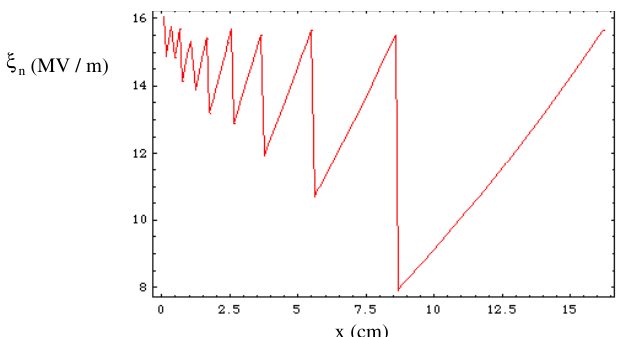
FIG. 7. (Color) Average axial field (cid:6) (cid:2) 60 (cid:8) by varying the amount (cid:1) h of the harmonic with (cid:1) n number jump during acceleration.